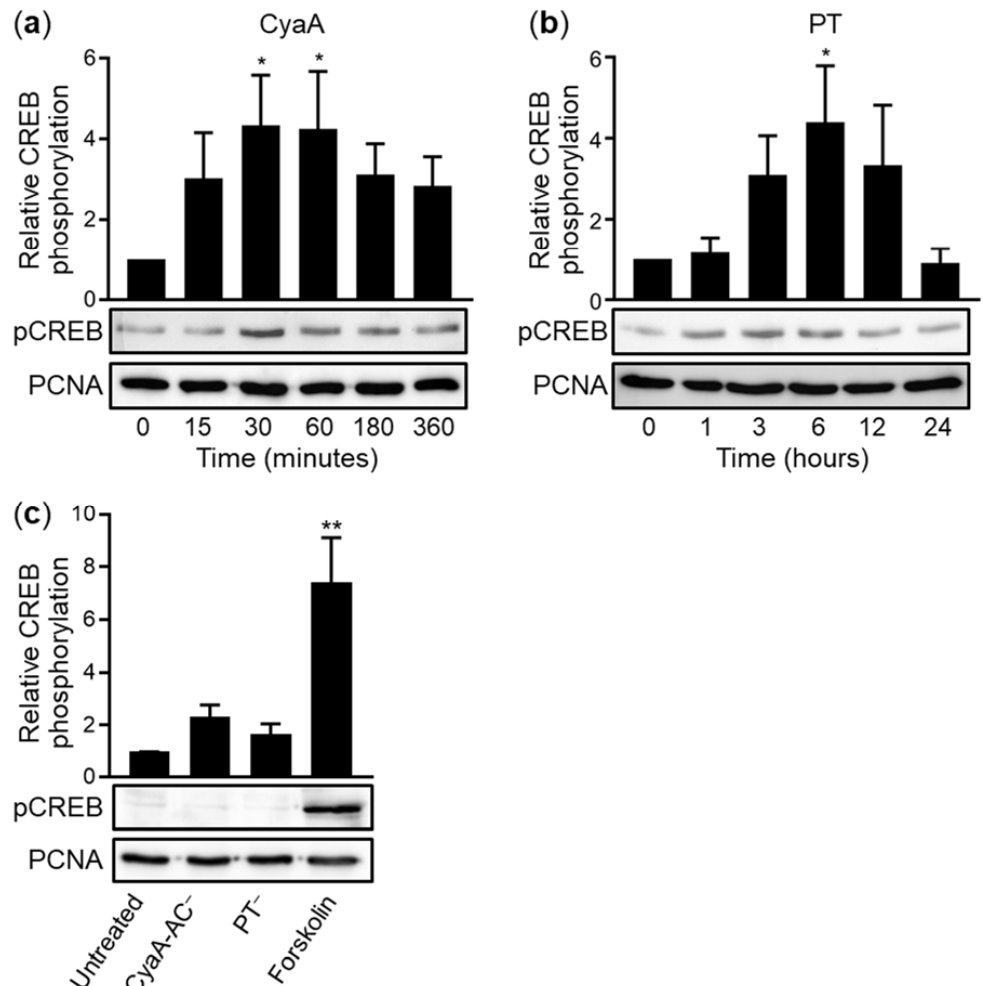
Figure 2. Purified CyaA and PT stimulate phosphorylation of CREB. Either 100 ng/mL of CyaA ( a ) or 100 ng/mL of PT ( b ) were added basolaterally to ALI-grown polarized VA10 cell layers for the indicated times. For comparison, 100 ng/mL of CyaA-AC – for 30 min, or 100 ng/mL of PT – for 6 h, were added as negative controls and 20 µg/mL of forskolin for 30 min was added as a positive control, respectively ( c ). Cell layers were lysed and nuclear lysates were analyzed by Western blotting. Activating phosphorylation of the Ser133 residue of CREB (pCREB) was detected using a pCREB-specific antibody. Immunoblots developed with anti-PCNA (proliferating cell nuclear antigen) antibody served as loading controls. Data represent mean with SEM from eight ( a ) or three ( b , c ) independent experiments. *, p < 0.05; **, p < 0.01 compared with untreated cell layers (time 0 in ( a , b )).